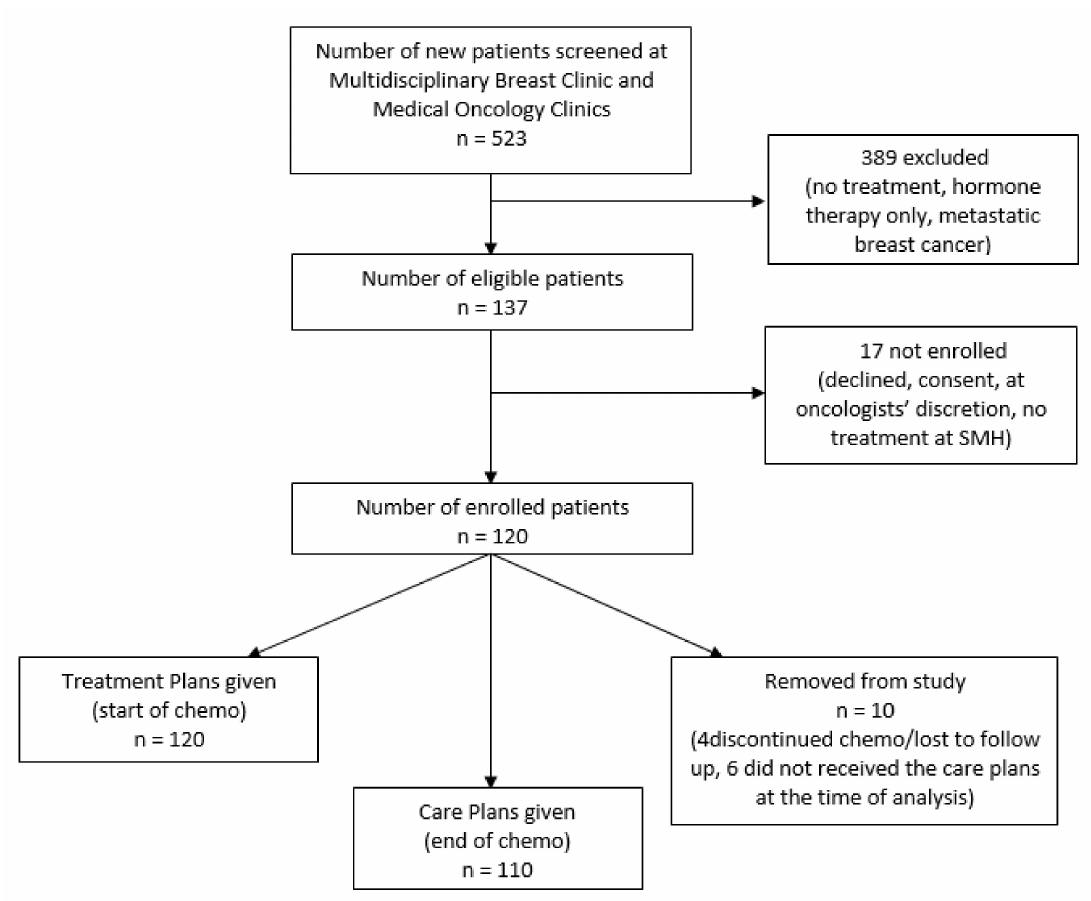
Figure 2. Patient recruitment flow chart. MDBC = multidisciplinary breast clinic, MOC = medical oncology clinic, BC = breast cancer, PTP = personalized treatment plan, PCP = personalized care